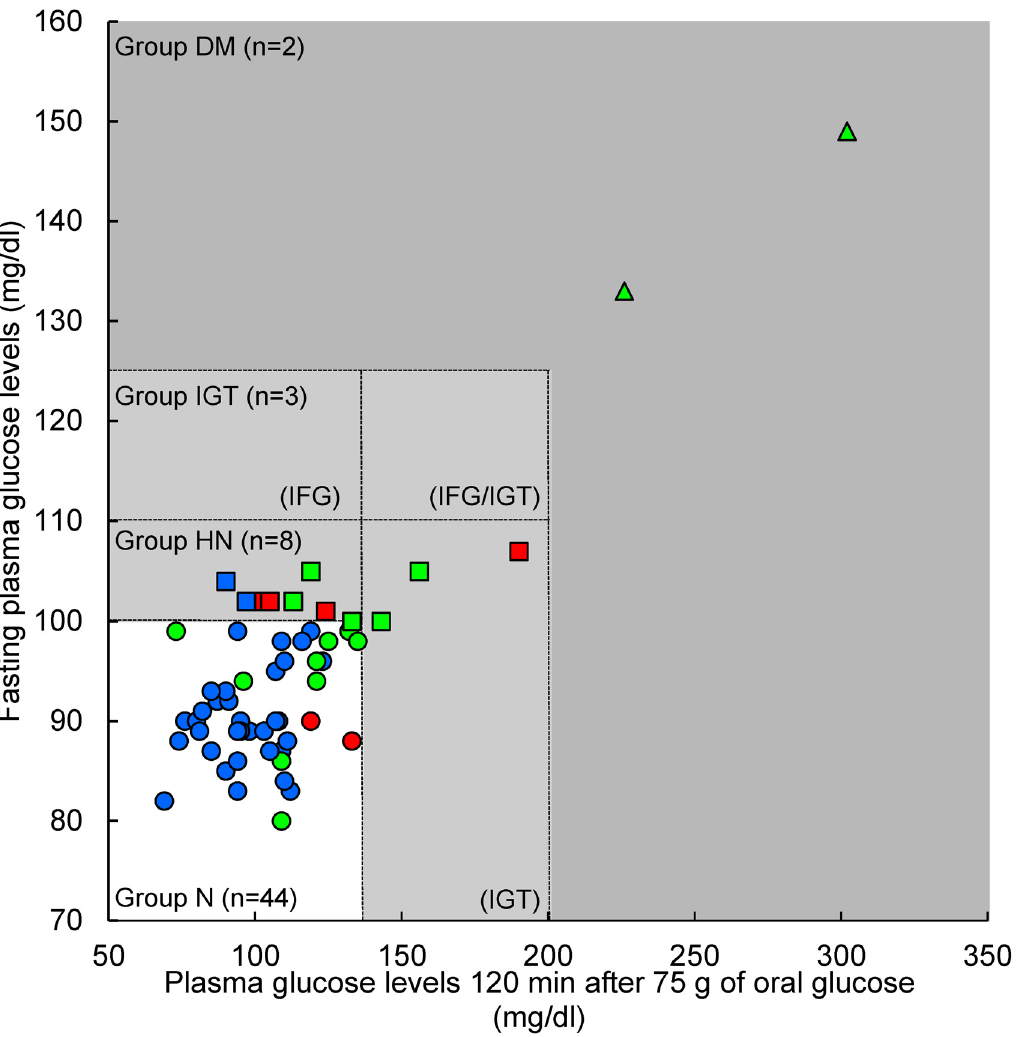
Fig 2. Classification of glucose tolerance using the oral glucose tolerance test. Circle, Group N (normal); square, Group HN+IGT ( “ high-normal ” and impaired glucose tolerance); triangle, Group D (diabetic). Blue, normal insulin resistance; red, borderline insulin resistance; green, insulin resistance determined by homeostasis model assessment of insulin resistance and Matsuda Index